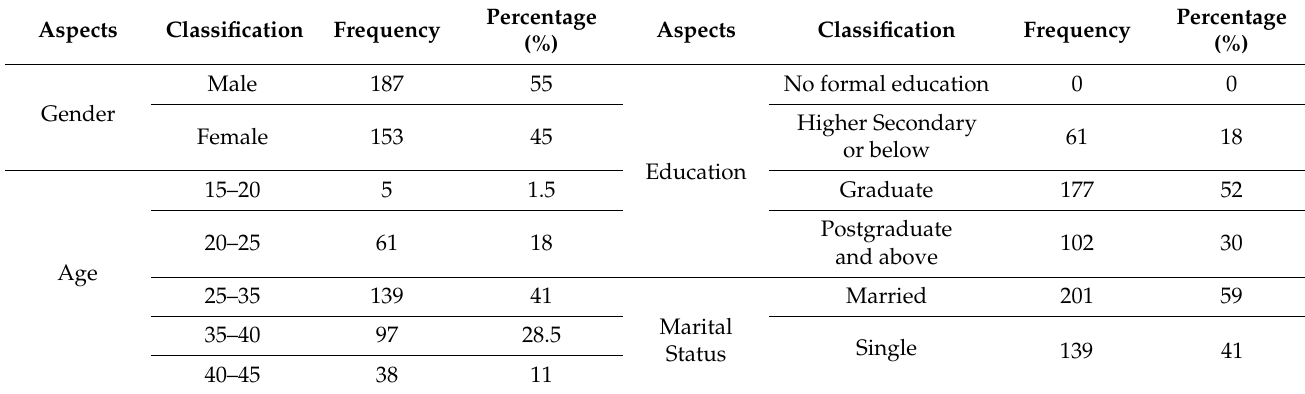
Table 1. Respondents’ profile.